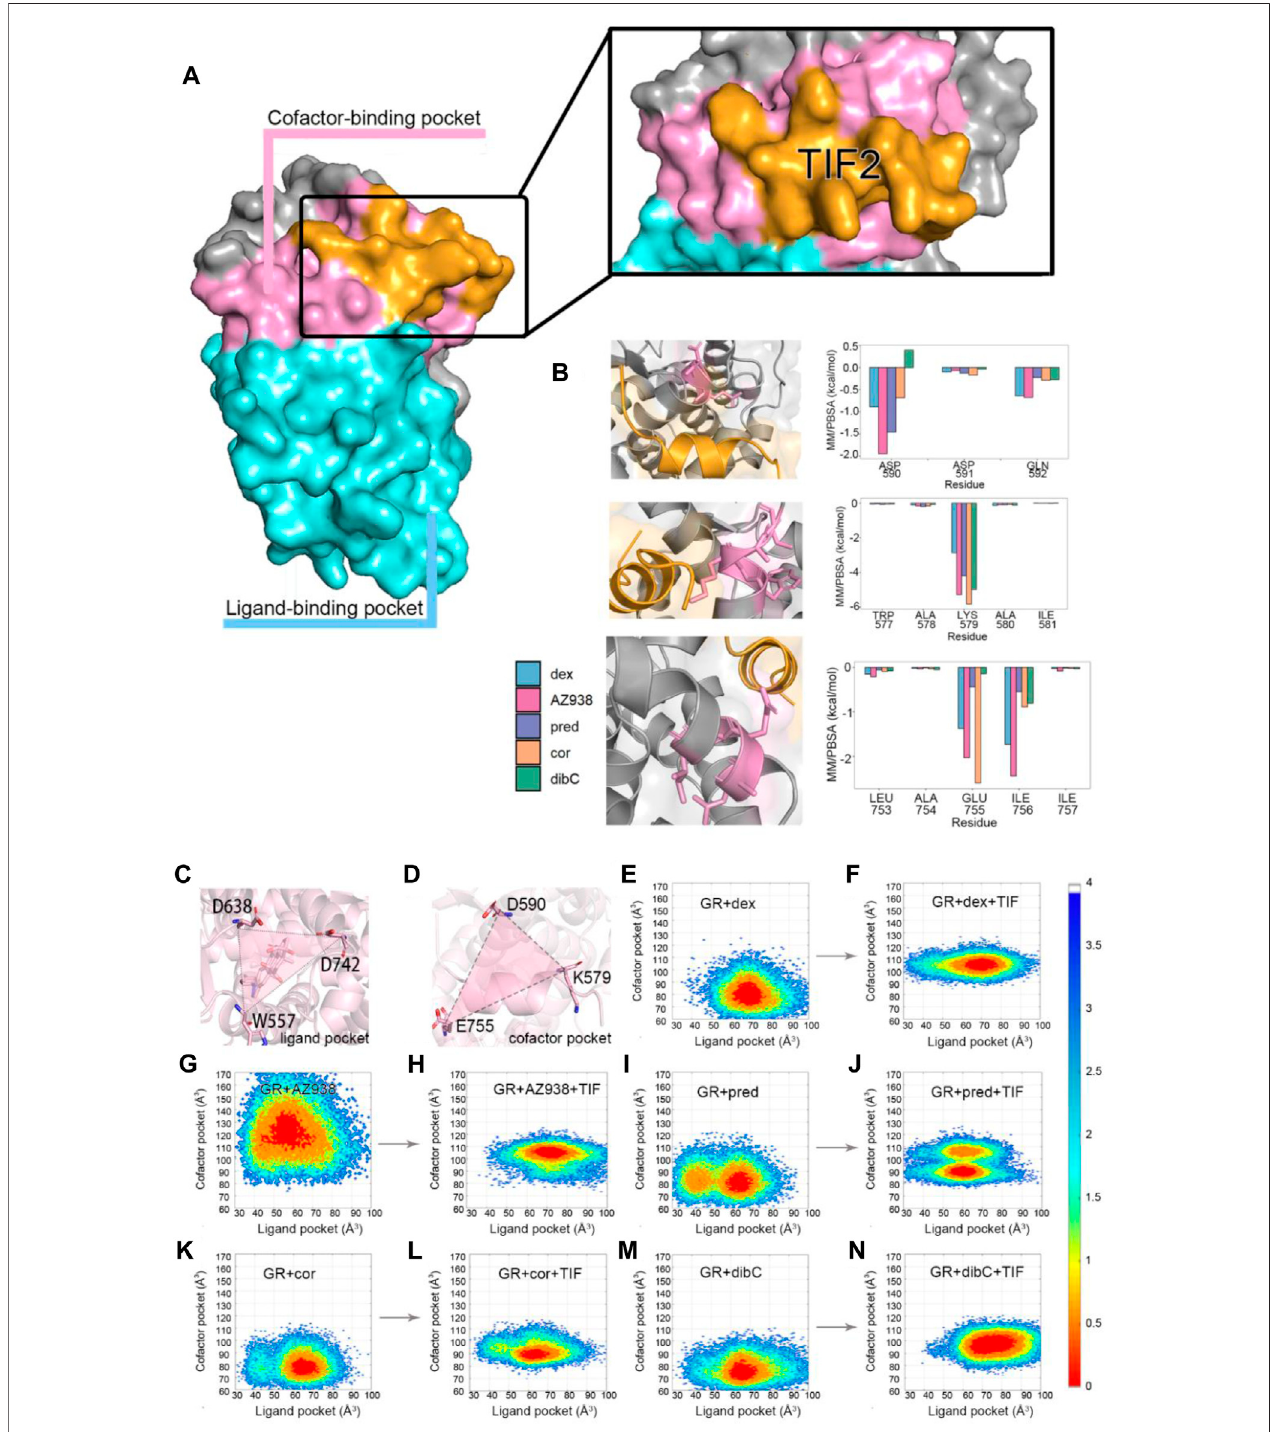
FIGURE 4 | (A) cartoon representation of two pockets. (B) MM/PBSA of three helices with crucial residues. (C) cartoon representation of parameter representing ligandpocket. (D) cartoonrepresentationofparameterrepresentingcofactorpocket.ConformationFELofdex,AZ938,pred,cor,anddibCwithorwithoutTIF2binding (E – N) . The landscape was generated with Δ D638-D742-W557 and Δ D590-K579-E755 .